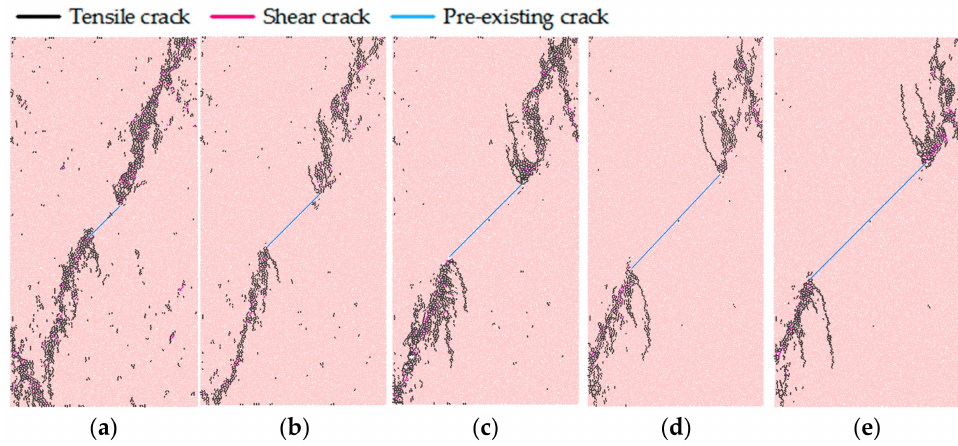
Figure 12. Cracks distribution in the main crack bearing granite at the moment of peak strength considering different crack lengths: ( a ) L = 0.006 m; ( b ) L = 0.01 m; ( c ) L = 0.014 m; ( d ) L = 0.018 m; ( e ) L = 0.022 m.